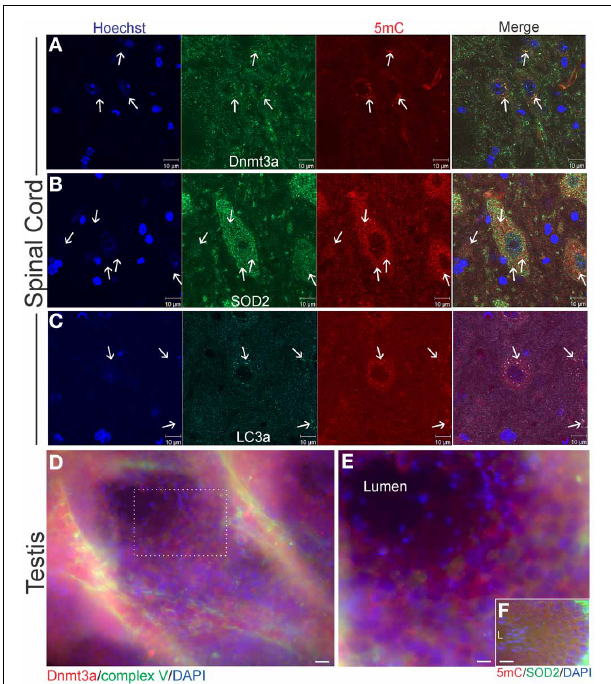
FIGURE 4 | Cellular localizations of Dnmt3a and 5-methylcytosine (5mC) in wildtype young adult mouse spinal cord and testes. (A) In 6–8 weeks old non-tg mice, Dnmt3a is present in the nucleus and in the cytoplasm of neurons in spinal cord. Extranuclear cytoplasmic Dnmt3a immunoreactivity (green) is localized diffusely and in discrete bodies (arrows). These discrete bodies also contain 5mC (red, arrows). Hoechst staining was used to identify cell nuclei. (B) Cytoplasmic 5mC is localized to mitochondria in neurons. Some mitochondria, identified by SOD2 immunoreactivity (green, arrows), in spinal cord colocalize with 5mC immunoreactivity (red, arrows). Many mitochondria also do not contain 5mC. The SOD2- and 5mC-positive bodies tend to be larger than normal mitochondria (white arrows). (C) 5mC is present in autophagosomes. Mouse spinal cord sections were immunostained for an autophagosome marker LC3A (green) and 5mC (red). Extranuclear 5mC immunoreactivity has a high colocalization with LC3A in autophagosomes (arrows). (D,E) Immunofluorescent localization of Dnmt3a (red) and complex V (green) in mouse testis. Cell nuclei are blue. Dnmt3a immunoreactivity (red) is enriched in cells in the seminiferous tubules of testes. The boxed area in D is represented at higher magnification in E which shows that Dnmt3a immunoreactivity (red) partly colocalizes (seen as yellow-orange) with mitochondria (green). Scale bars: 30 µ m (D) ; 15 µ m (E) . (F) Immunofluorescence for 5mC (red) and SOD2 (green) in mouse testes. Cell nuclei are blue. 5mC immunoreactivity (red) partly colocalizes (seen as yellow-orange) with mitochondria (green). Mature spermatozoa with scant mitochondria are seen at left in seminiferous tubule lumen (L). Scale bar = 30 µ m.